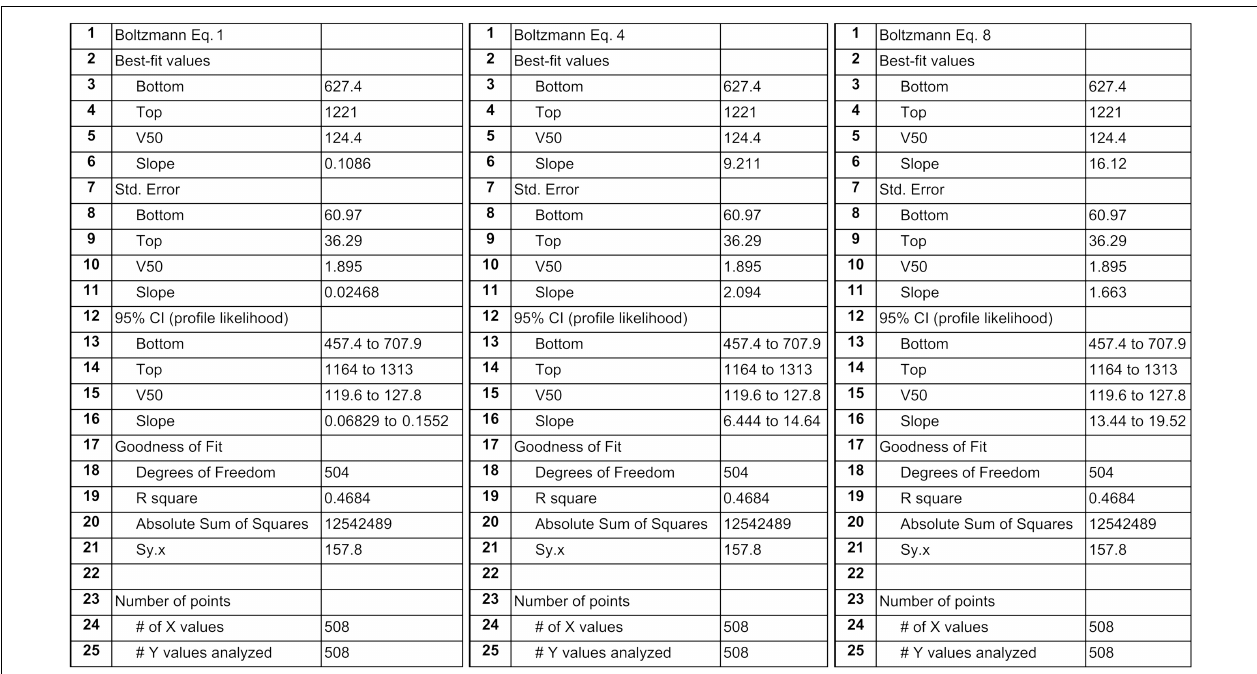
FIGURE 3 | Screenshots of GraphPad R (cid:13) Prism report tables after fitting different Boltzmann sigmoidal functions to real cardiac baroreflex data. We used the nonlinear curve fitting tool of GraphPad Prism (GraphPad, RRID:SCR_002798) to fit the four parameters of the Boltzmann sigmoidal functions related to Equation 1, Equation 4, and Equation 8 to experimentally obtained cardiac baroreflex data from a previous study (Heusser et al., 2016). The result tables report identical values for the optimized parameters Bottom, Top, and Midrange (V50). However, Slopes in line #6 are different. The only Slope that corresponds to the actual slope of the curve (see slope triangle in Figure 4 : 16.12 ms/mmHg) is reported by our proposed WYSIWYG Equation 8 as can be expected according to Results section “The [S]lope parameter’s value really represents the slope of the modified Boltzmann sigmoidal curve at the inflection point.” Furthermore, the screenshots exemplify that, after parameter fitting, the resulting graphs are absolutely identical since the Goodness of Fit quantifiers are identical (lines #19–21) which is in agreement with the exactly overlapping curves in Figure 4 . Sy.x is a variant of the standard deviation of the residuals that takes the degrees of freedom into account: Sy.x = sqrt [(sum of squared residuals) / (n – degrees of